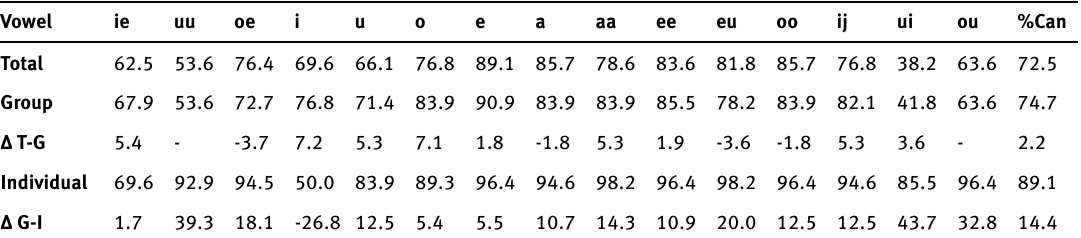
Table 5. Degree of improvement for the percentages of canonical classifications per target vowel and per condition (“Total”(T)→ “Group”(G)→ “Individual” (I)) for all 15 Dutch vowels produced by Spanish learners (F1, F2 + duration); Vowel = target vowel, Δ = difference between the percentages across conditions, %Can = average percentage of canonical classifications .